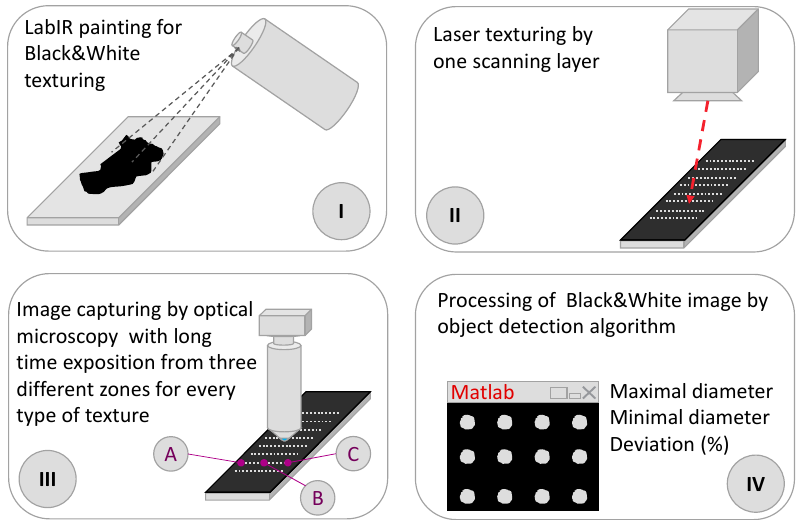
Figure 2. Sketch of the methodology for the determination of the surface dimple diameter by using LabIR paint, an optical microscope and software analysis.